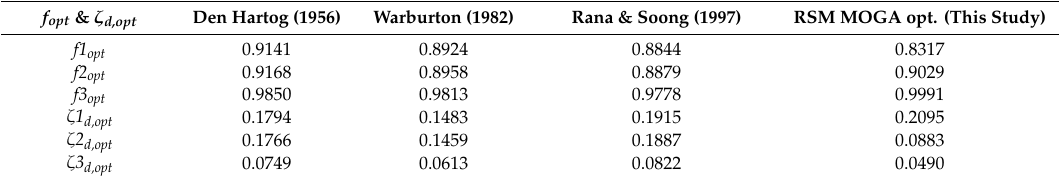
Table 3. TMD optimal design values for the NUREG / CR-1677 Benchmark piping system: f opt & ζ d,opt .